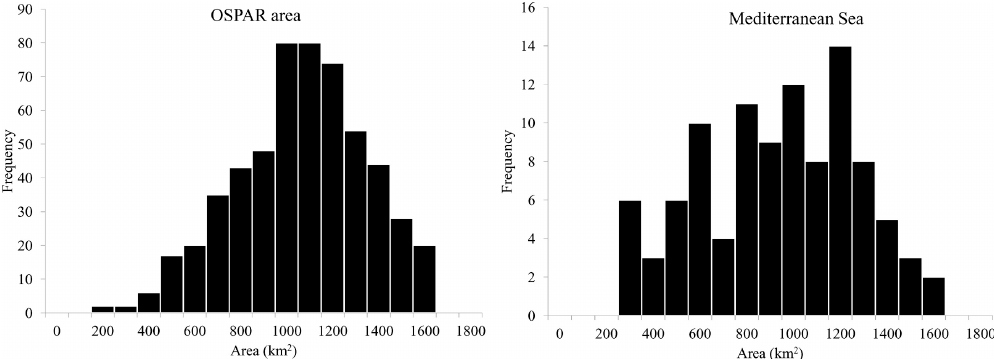
Fig. 6. Histogram of the predicted seamount area (km 2 ) distribution of OSPAR (left) and Mediterranean (right) seamount-like features. Bin size is 100m.